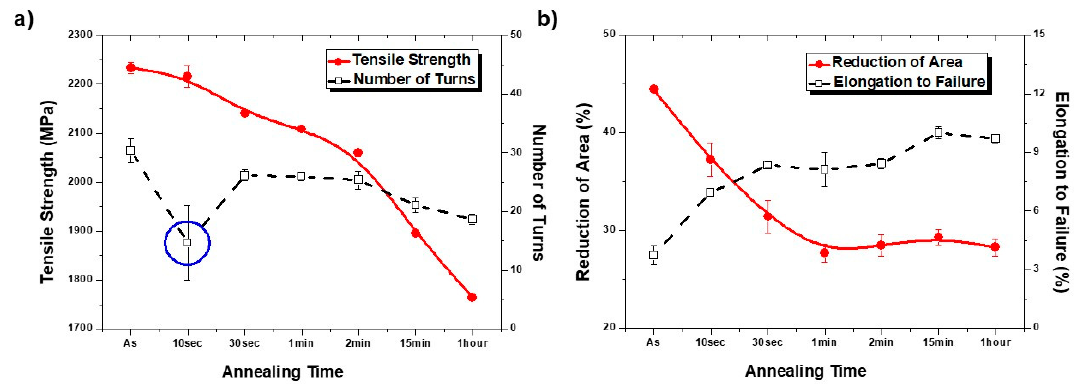
Figure 3. The variations of ( a ) TS and NT and ( b ) RA and EL with annealing time at 500 °C in hyper-eutectoid steel wires cold drawn with a strain of 1.95.